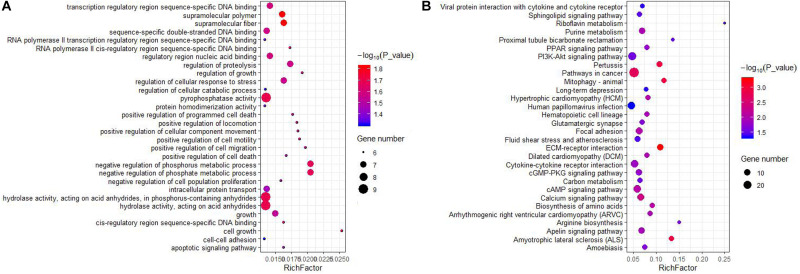
GO and KEGG enrichment of trans-target genes of DELs. (A) Top30 GO enrichment terms. (B) Top30 KEGG pathway enrichment terms. The horizontal axis represents a rich factor and the vertical axis represents the pathway. The size of the bubble indicates the number of target genes enriched in the pathway, and the color of the bubble represents a different P-value range. Rich Factor is the ratio of differentially expressed gene numbers annotated in this pathway terms to all gene numbers annotated in this pathway term.